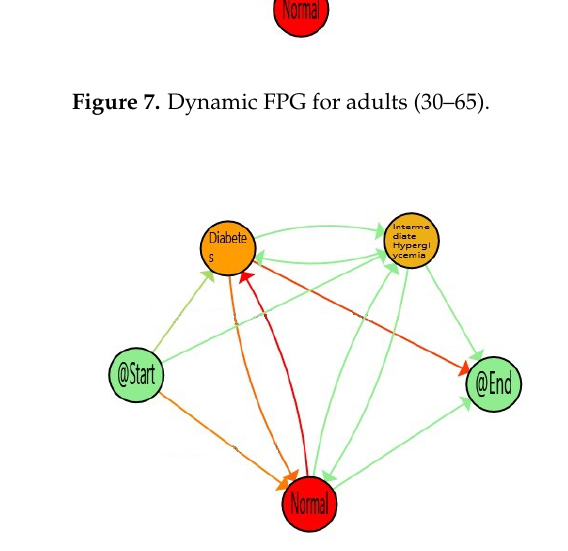
Figure 8. Dynamic FPG for young aduls